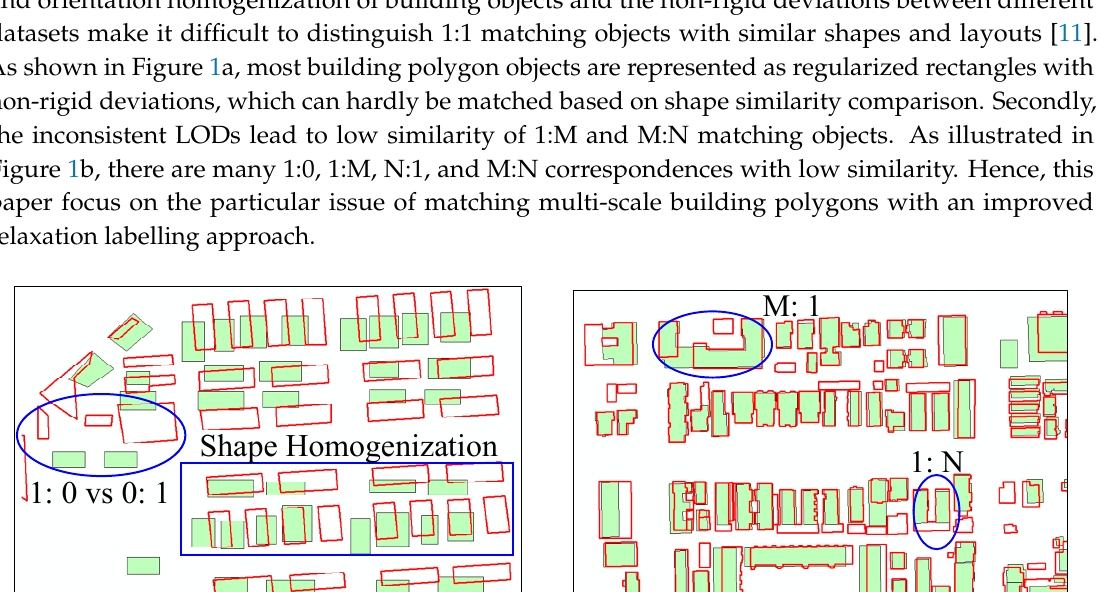
Figure 1. Complex difficulties in matching multi ‐ scale building polygons: ( a ) shape homogenization and non ‐ rigid deviations between building features; ( b ) 1:M and M:N matching caused by inconsistent levels of detail (LODs).